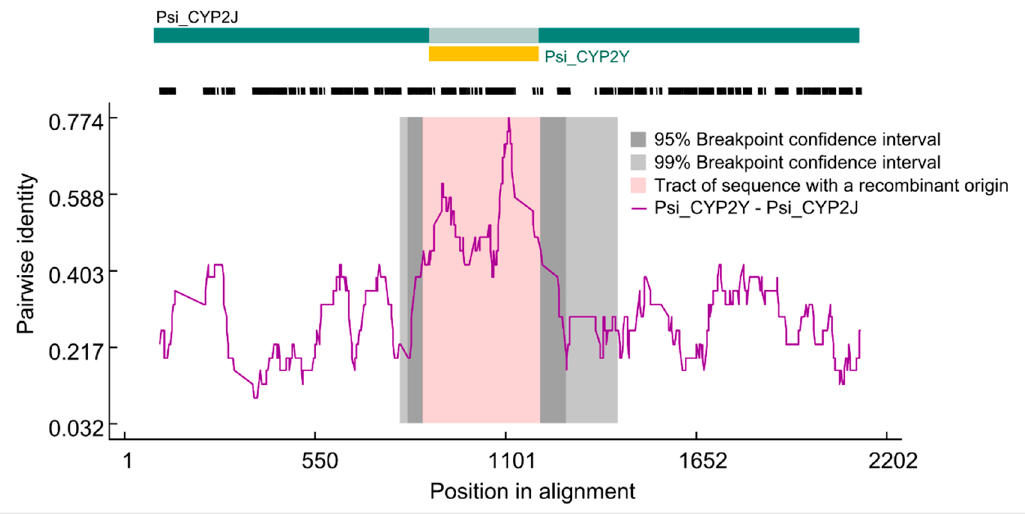
Figure 3. Identification of recombination events between the Psi_CYP2J and Psi_CYP2Y genes. Recombination events were inferred by the RDP (Recombination Detection Program) method. The broken black horizontal line indicates the sequence on hand for the genes at issue.